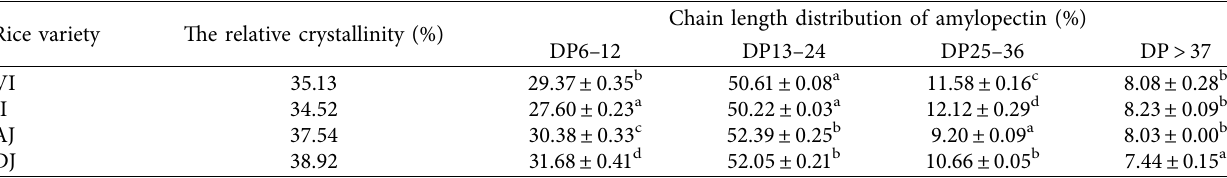
Table 3: Branch chain-length distributions and the relative crystallinities of amylopectin in waxy rice starches ∗ . Rice